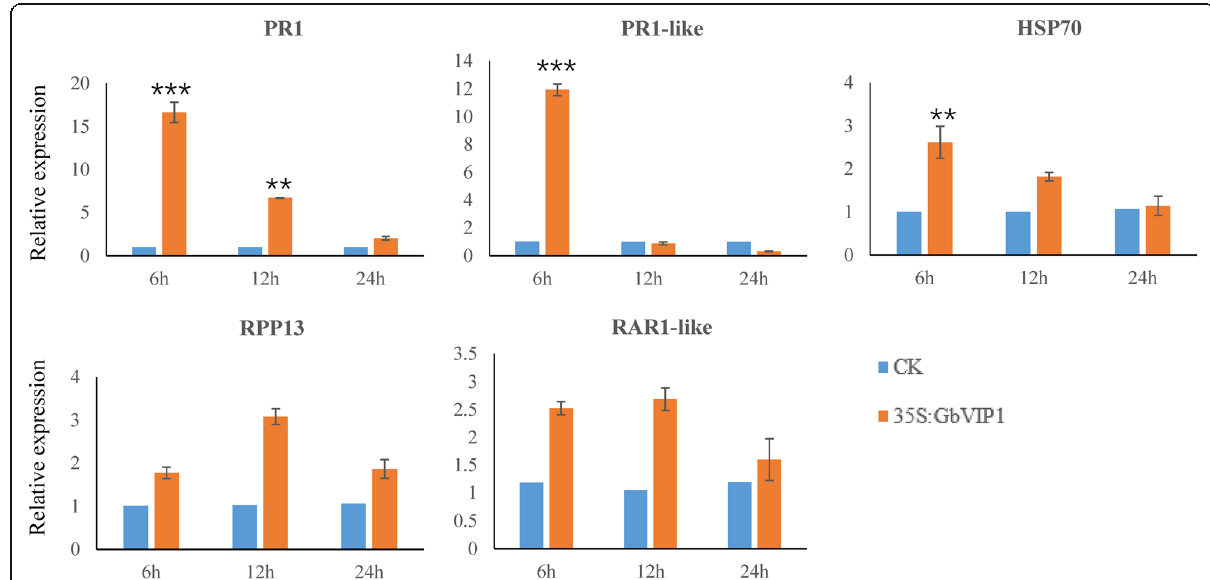
Fig. 6 Expression level of disease resistance-related genes in transgenic tobacco plants expressing GbVIP1. 35S:GbVIP1 represents transgenic tobacco lines and CK represents control tobacco lines. * Significant